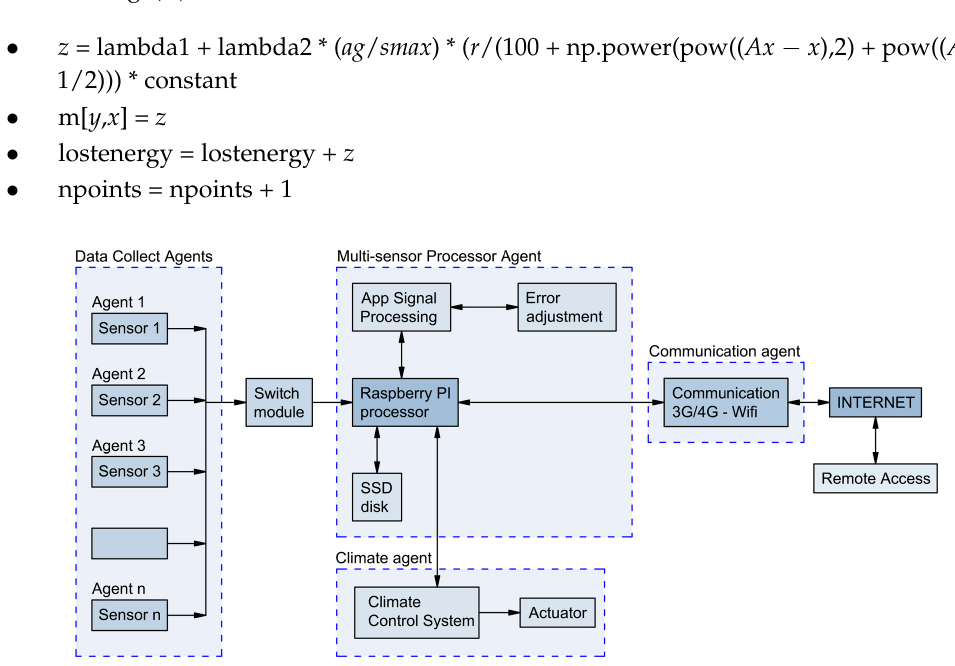
Sensors 2017 , 17 , 2848 Figure 21. Outline of the architecture of the Multi-sensor Processing System. Figure 21. Outline of the architecture of the Multi-sensor Processing System.